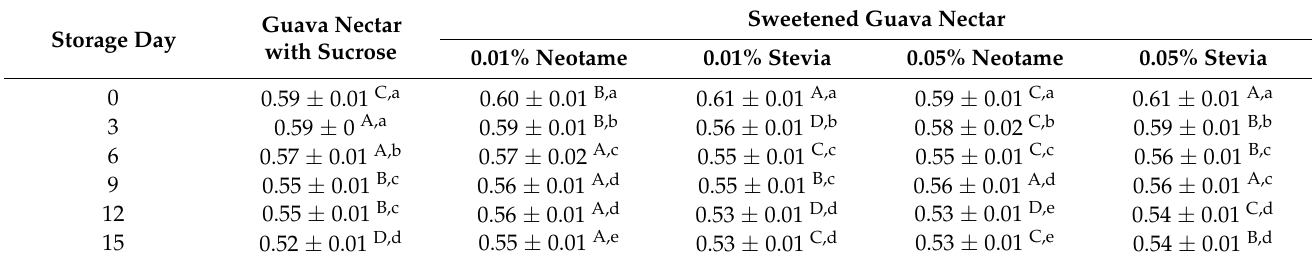
Sweetened Guava